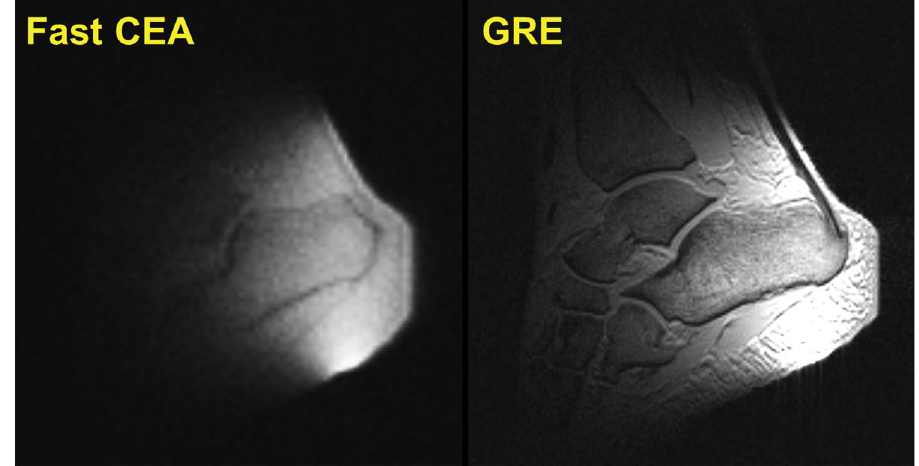
Figure 10. A sagittal slice of the fast CEA image of a human ankle (left), and the GRE image as anatomical reference